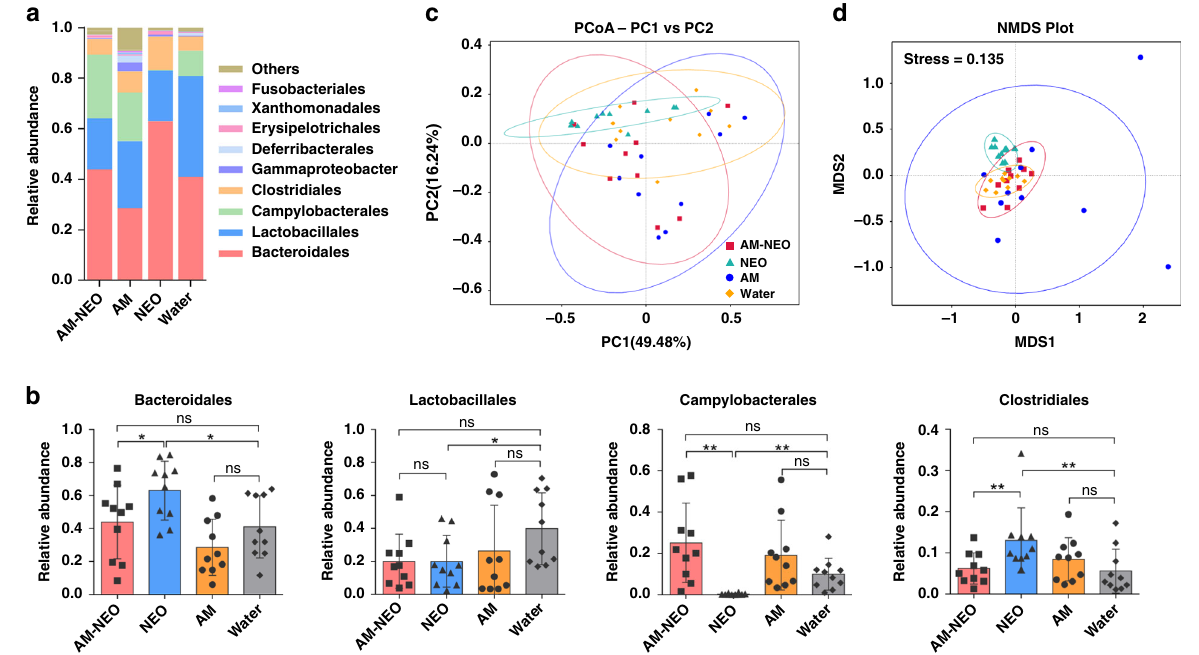
Fig. 4 AM vesicle cloak alleviates neomycin induced damages to the gut microbiota in normal mice. a Average bacterial taxonomic pro fi ling at order level of the gut microbiota in four groups. b Relative abundance of the bacterial order obtained in fecal microbiota from the LefSe results. Data are shown as mean ± SD, n = 10 mice per group and each dot represents data from an individual animal. A single asterisk indicate p -values of <0.05, double asterisks indicate p -values of <0.01, ns, no statistical signi fi cance (two-tailed Student ’ s t -test). Source data are provided as a Source Data fi le. c Nonmetric multidimensional scaling score plot based on Bray-Curtis. d UniFrac-based PCoA score plot based on weights